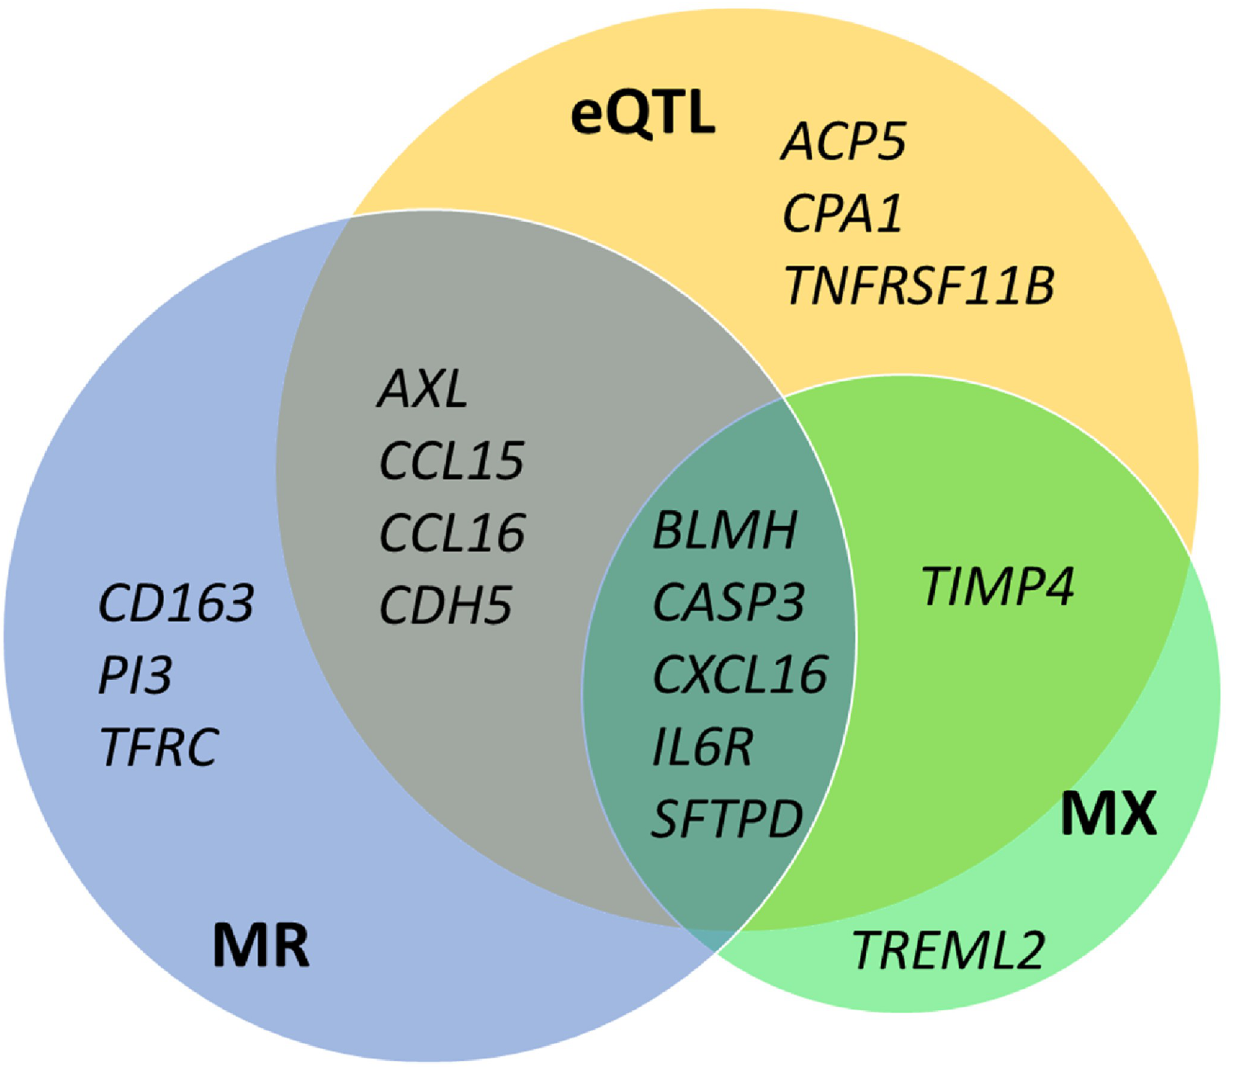
Fig 3. Overlap of genes with negative correlation to protein levels according to different analysis strategies. We present the genes with negative protein correlations for more than 75% of the significant tissues according to MetaXcan (MX), negative causal effect estimates according to Mendelian Randomization (MR), and opposite effect direction of eQTLs and pQTLs (see also Tables